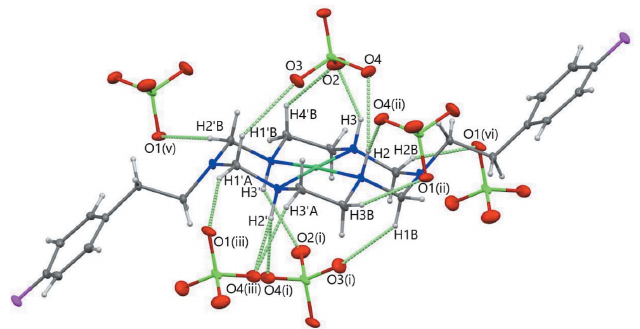
Figure 2 Hydrogen-bonding interactions involving the perchlorate anions in the crystal packing [Ni L ](ClO 4 ) 2 . Light-green dashed lines indicate N— H (cid:3)(cid:3)(cid:3) O and C—H (cid:3)(cid:3)(cid:3) O hydrogen-bonding interactions. Symmetry codes: (cid:5) z ; (ii) 1 (cid:5) x , 1 (cid:5) y , 1 (cid:5) z ; (iii) x , (cid:5) 1 (cid:5) x , (i) 1 (cid:5) x , y , 1 + y , 1 (cid:5) z ; (v) 3 2 2 2 1 (cid:5) y , 1 (cid:5) z ; (vi) (cid:5) 1 (cid:5) y , (cid:5) 1 + x , 1 + z . Only one of the whole-molecule 2 2 2 2 disorder [Ni L ] 2+ components and the major component of the perchlorate anion are shown.